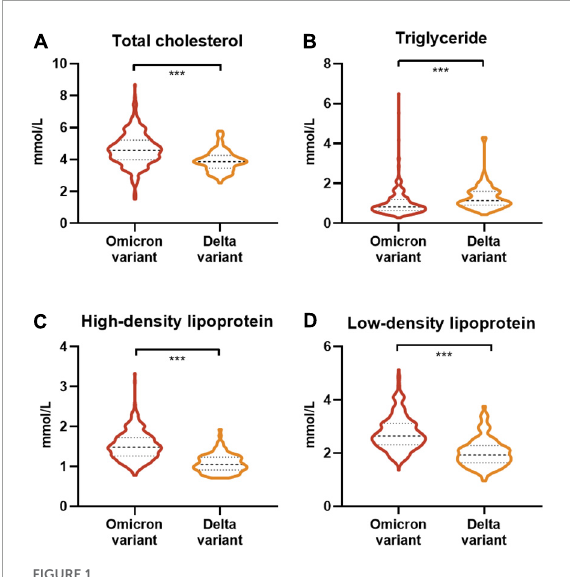
FIGURE1 Lipid laboratory tests between patients infected with the Omicron variant or Delta variant on admission to the hospital. (A) Comparison of total cholesterol in patients infected with the Omicron or Delta variant. (B) Comparison of triglyceride in patients infected with the Omicron or Delta variant. (C) Comparison of high-density lipoprotein in patients infected with the Omicron or Delta variant. (D) Comparison of low-density lipoprotein in patients infected with the Omicron or Delta variant. The asterisk indicates a statistically significant difference compared with delta patients. *** means P < 0.001.